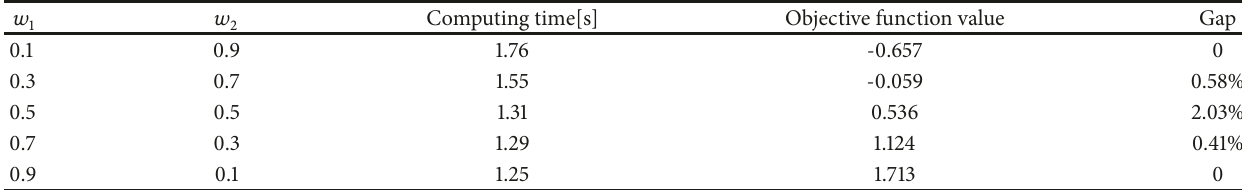
Table 6: Comparison with different value of weight coefficients for case study-A.